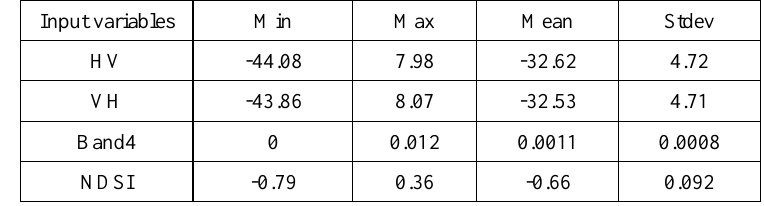
Table 2. Statistics of input variables in study